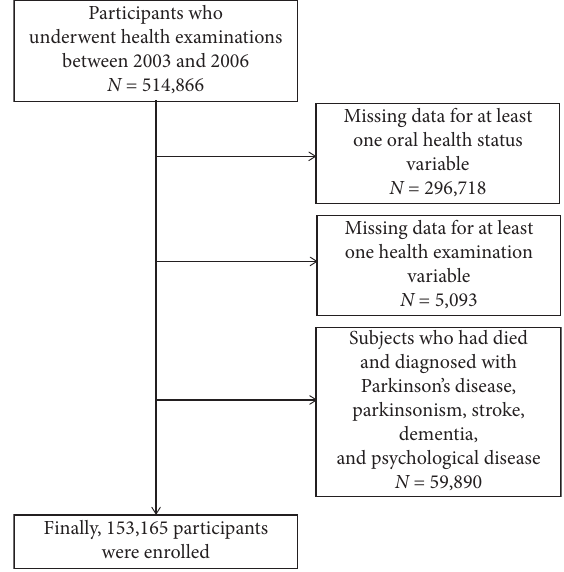
Figure 1: Flowchart of the study